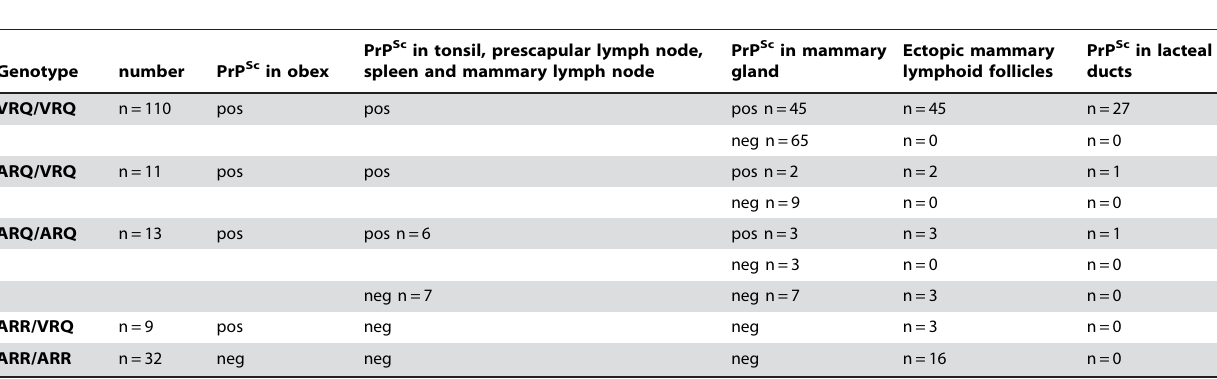
Table 1. PrP Sc in central nervous system, lympho-reticular system, mammary gland and milk duct lumen of natural scrapie exposed ewes bearing various genotypes at codons 136, 154 and 171 of the PRP gene.